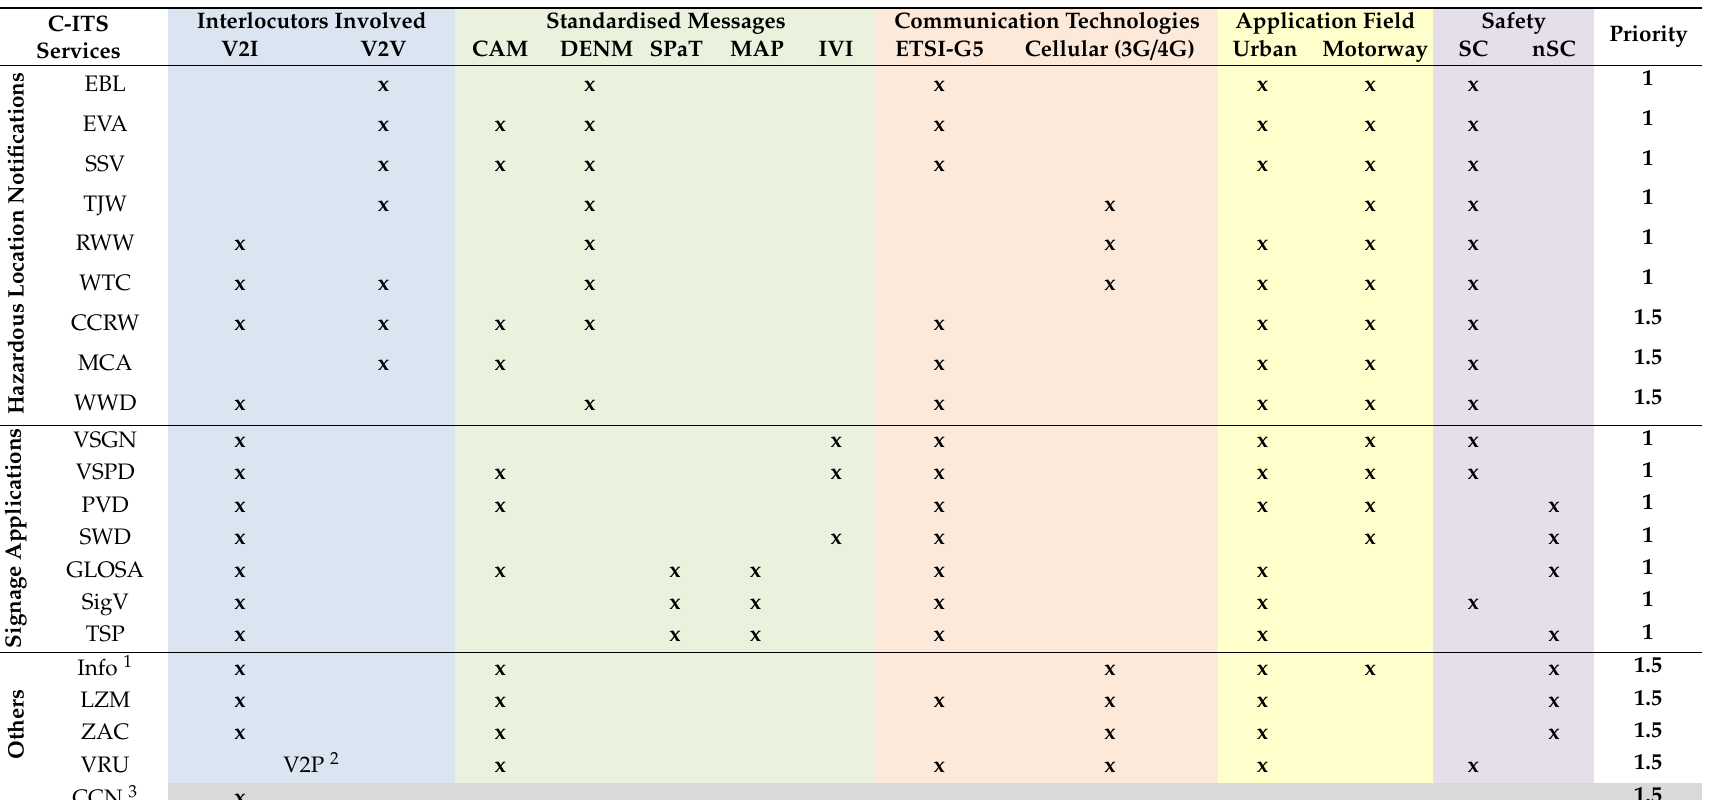
Table 1. Classification of C-ITS services (source: